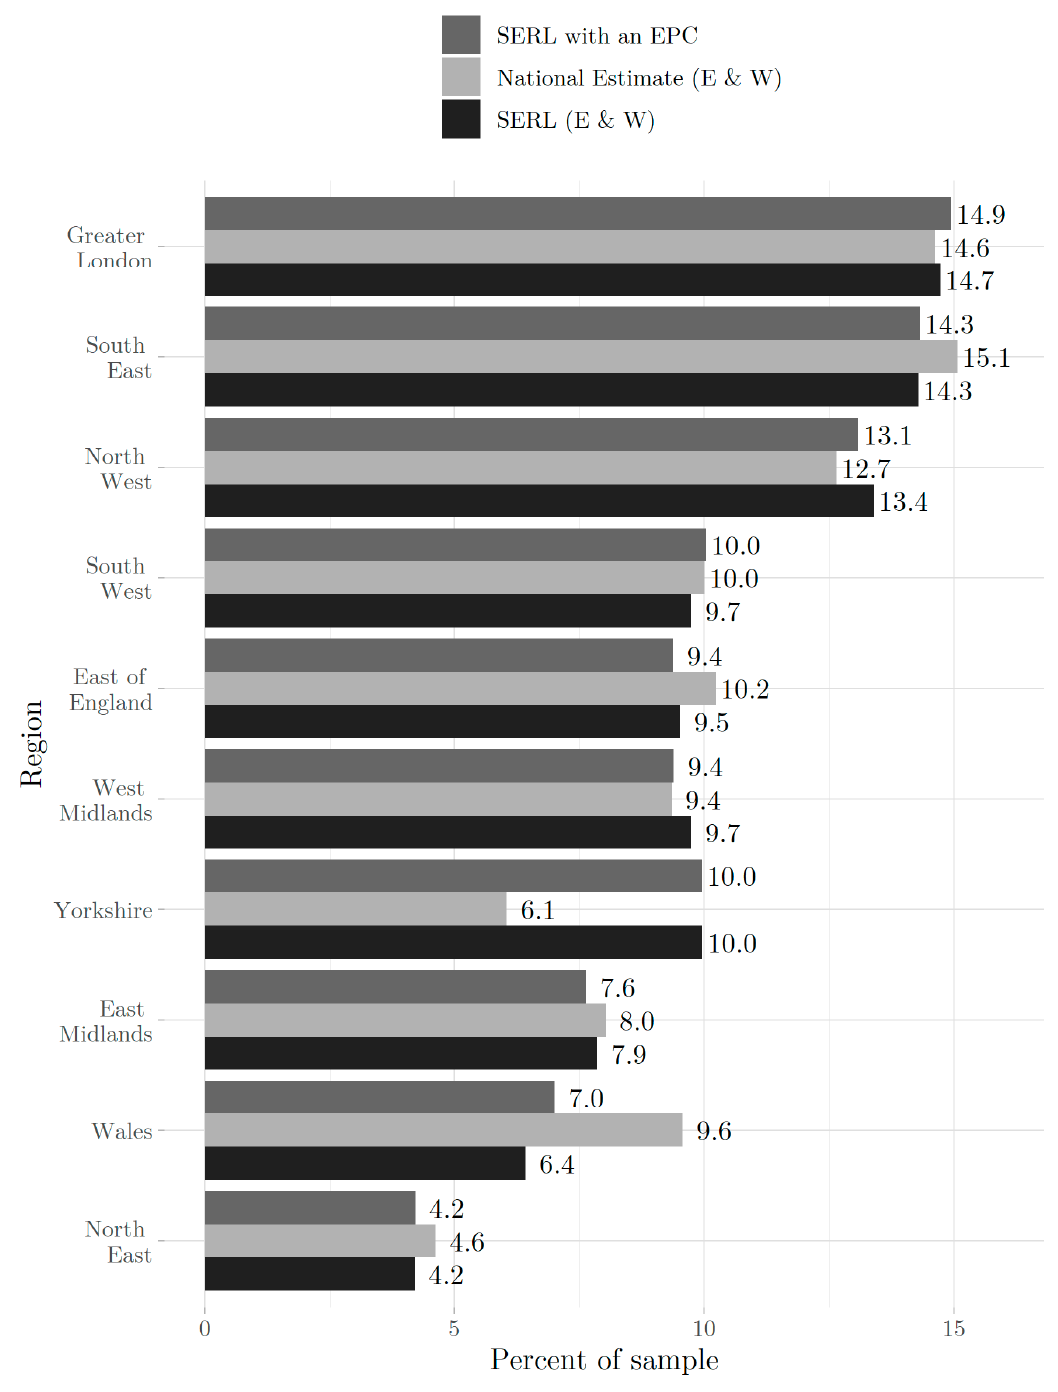
Figure 20. Regional split of dwellings in SERL (England and Wales), national estimate from Address Base (England and Wales), and the SERL sample of participants with an EPC (Scottish data to be included in future).